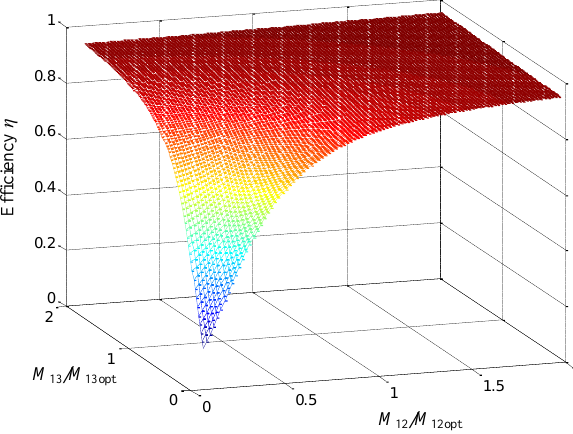
Figure 2. Power transfer efficiency versus mutual inductance levels under the best matching condition.